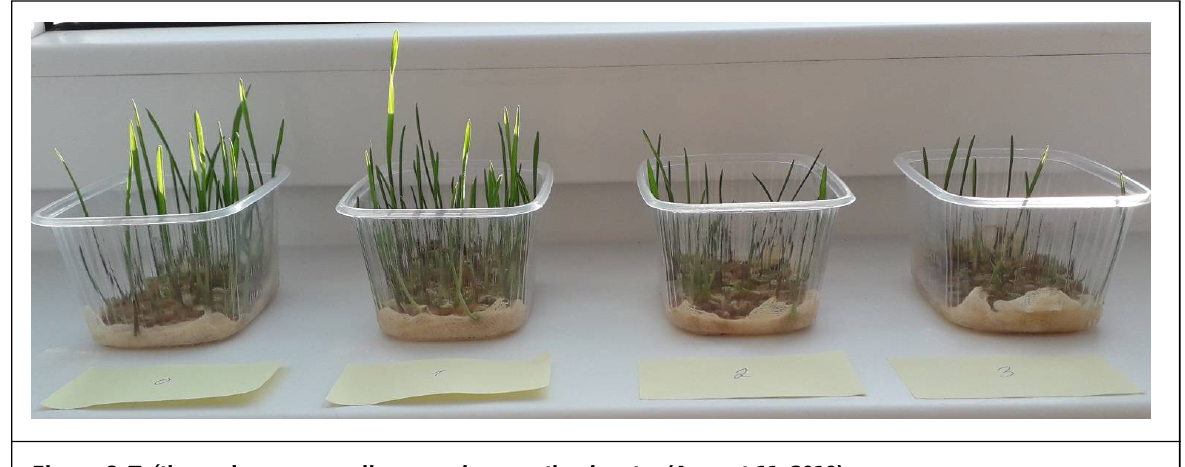
Figure 8: Tríticum durum on ordinary and magnetized water (August 11, 2019) By the end of the experiment, the Sample 0 overtook the Sample 1 in the growth rate, but the Sample 1 still had the largest number of sprouts from all samples. In this case, the Sample 1 was the first to show the signs of wilting of the sprouts (Figure 9).